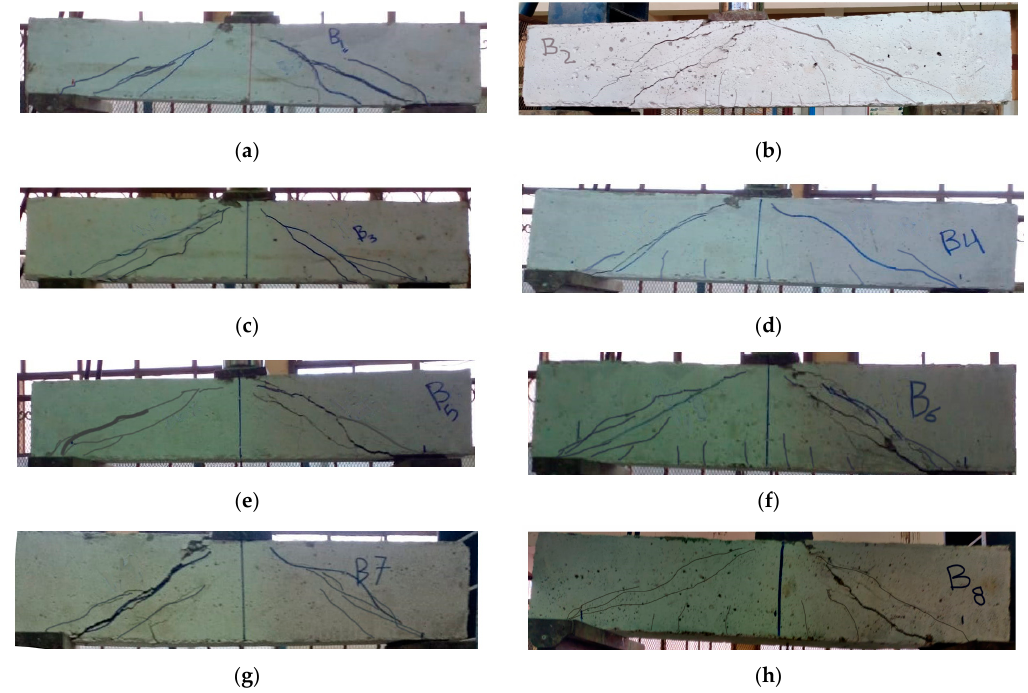
Figure 5. The crack patterns of the tested beams. ( a ) Crack pattern of beam B1; ( b ) Crack pattern of beam B2; ( c ) Crack pattern of beam B3; ( d ) Crack pattern of beam B4; ( e ) Crack pattern of beam B5; ( f ) Crack pattern of beam B6; ( g ) Crack pattern of beam B7; ( h ) Crack pattern of beam B8.